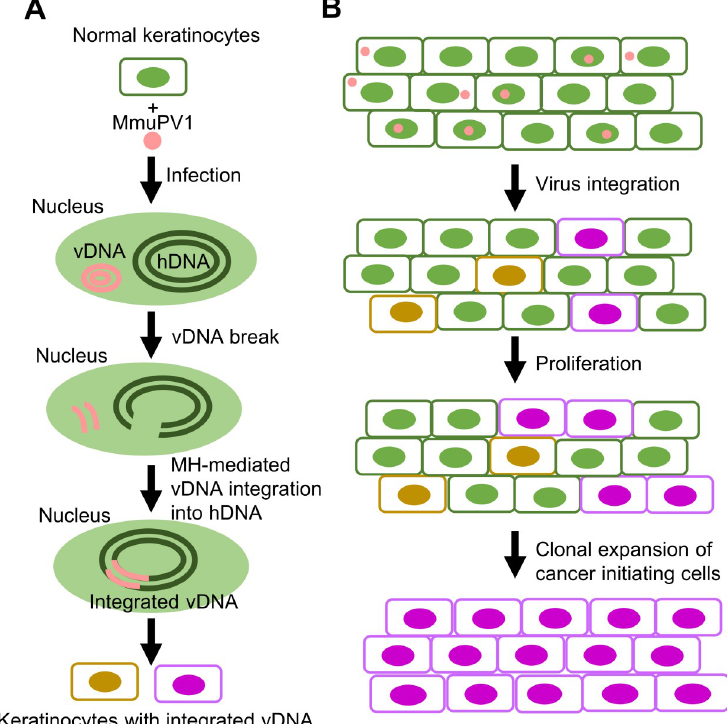
Fig 9. Proposed model of the role of integrated MmuPV1 DNA in tumorigenesis. After virus infection, MmuPV1 induction of the host DNA damage response and activation of the cellular DNA repair machinery enhance the breakage and recombination of both the viral and host genomes. The linearized viral genomes (vDNA) could be fused to any nicked or damaged region of the host genome (hDNA) most likely by a microhomology-mediated DNA repair pathway ( A ). MmuPV1 integration into the host genomic DNA appears to be mostly random; however, what we detected in our experiments was modified by post-integration selection. Integrated MmuPV1 DNA accumulates over time following MmuPV1 infection, contributing to tumor formation. Clonal expansion of cells that express viral E6 and E7 from the integrated MmuPV1 DNA through the linearized E2 region [14–16], leads to tumor progression and ultimately to cancer ( B